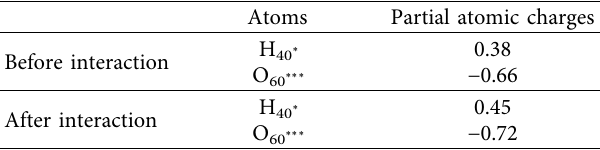
Table 2: Te phospholipid ∗ and cholesterol ∗∗∗ atoms’ partial atomic charges before and after the